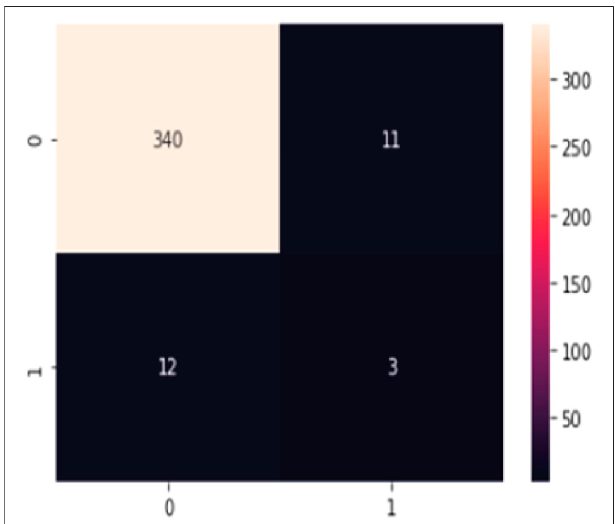
FIGURE 7 | Confusion matrix for the randomized training EQ catalog at the Nokalakevi station — the timings of EQs in the corresponding output column are randomized (the occurrence times were displaced according to the rule — see before). Compare with the original Figure 6A .